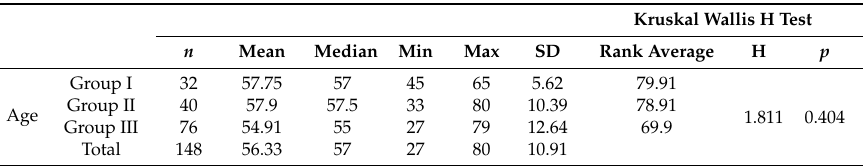
Table 1. Age distribution of according to groups.